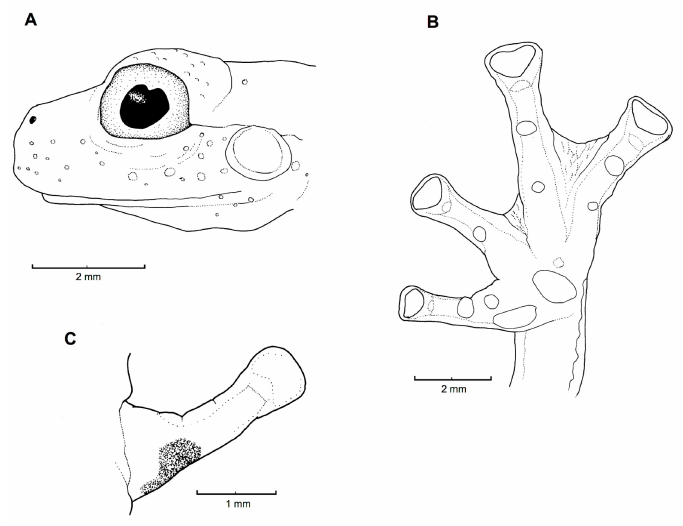
Figure 51. Centrolene peristicta , KU 178148. ( A ) Head in lateral view. ( B ) Hand in ventral view. ( C ) Dorsal view of Finger I, showing nuptial pad. Illustrations by Juan M. Guayasamin. Color in life (Figure 50): Dorsum green with minute yellowish–white flecks and small dark grey spots; upper lip white; region below eye with small white warts; bones green; vocal sac green; upper flanks green with minute white spots; lower flanks cream with minute white spots; venter yellowish cream; fingers and toes dull yellow green; ulnar fold with thin white line or with low white ulnar tubercles; outer tarsal fold with low white tubercles; small white tubercles just posterior to cloaca. Color in ethanol: Dorsal surfaces of head, body, and limbs lavender with minute white spots and small black spots; margin of upper lip white; region below eye with small white warts; white tubercles just posterior to cloaca. White parietal peritoneum covers anterior half of venter; white pericardium; clear peritoneum on liver and kidneys; digestive tract partially or completely covered with white